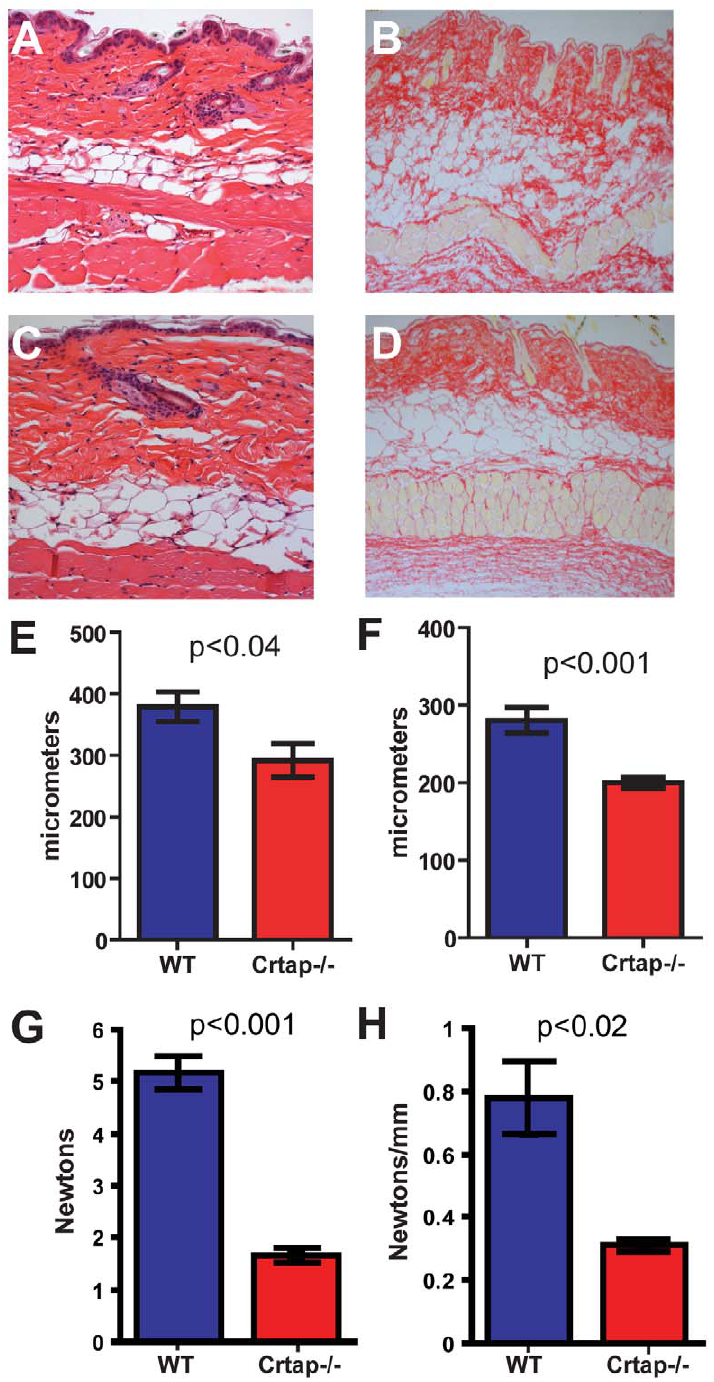
Figure 3. Skin defects in Crtap-/- mice. ( A ) Adult Crtap-/- skin H&E section at 20X shows thinning of the dermis relative to wildtype ( C ). ( B ) Adult Crtap-/- skin picrosirius red section at 20X shows disorganization of tissue layers and ECM in contrast to wildtype ( D ). Quantification of adult total skin thickness ( E ), measured from epidermis to bottom of adipose layer, and adult dermis thickness ( F ) demonstrates thinning of Crtap-/- skin. Significant decrease in measurements of skin peak load (G) and stiffness (H) in Crtap-/- skin compared to wild-type controls.